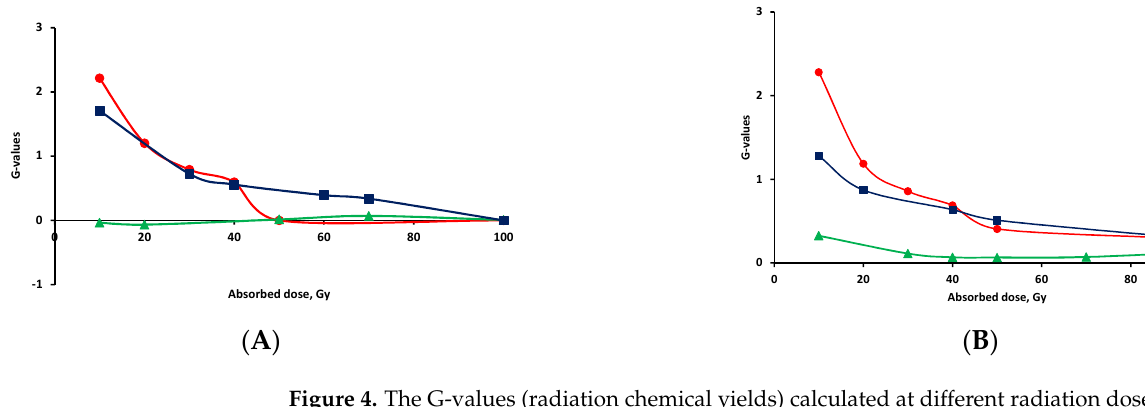
Figure 2. Efficiency of sertraline degradation and ionic products formation in aqueous solution saturated before irradiation with N 2 O- • OH radicals predominate: ( ● )-sertraline 1 mg/L degradation, ( ■ )-Cl − formation, (  )-NO 3 − formation, ( ♦ )-NO 2 − formation.